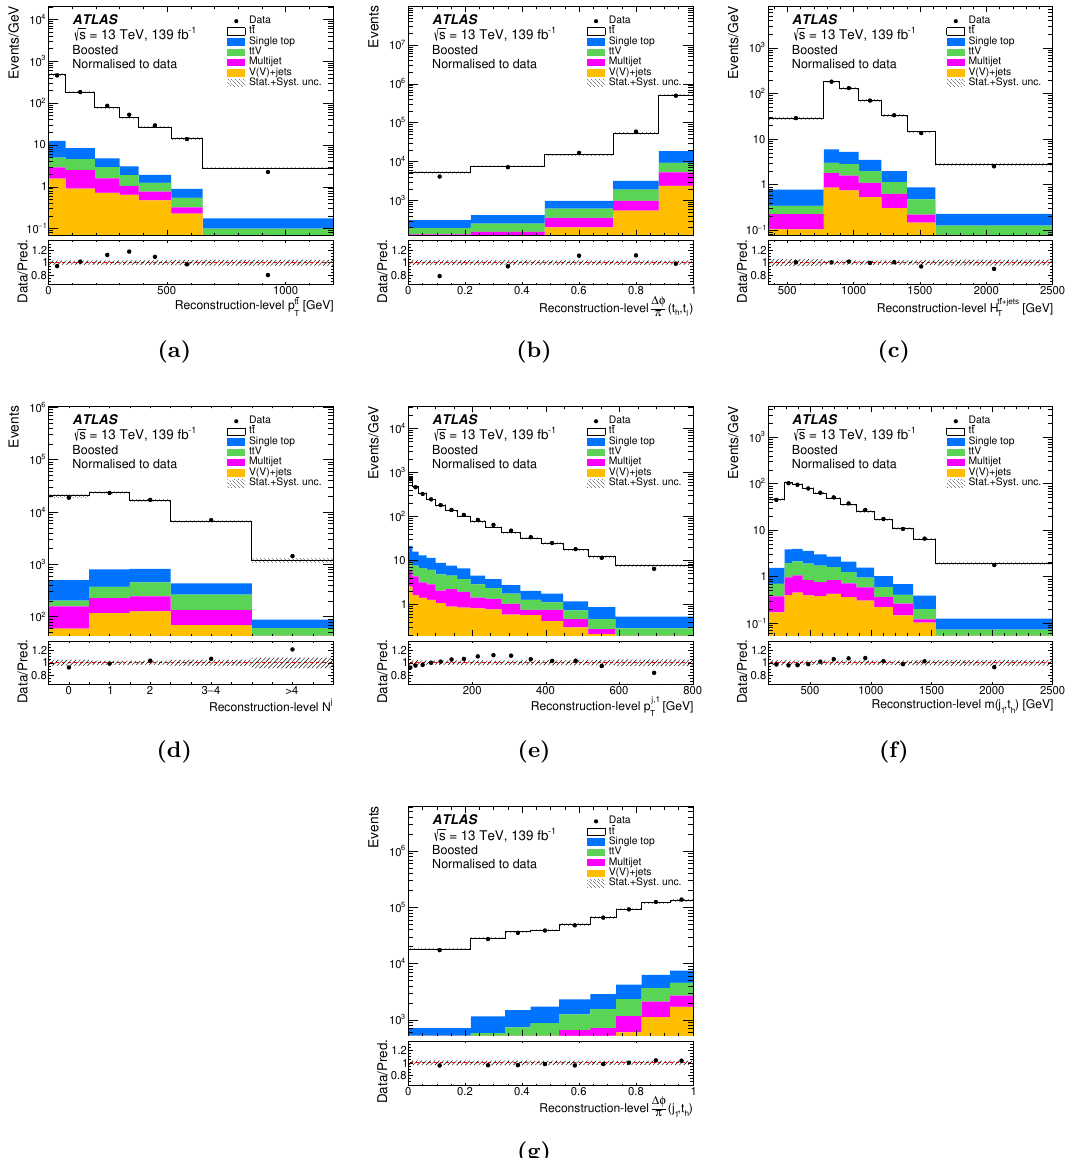
Figure 5. Distributions of observables sensitive to jets produced in association with the t ¯ t system: (a) p t ¯ t , (b) ∆ φ ( t ) , (c) H t ¯ t +jets , (d) N j , (e) p j, 1 , (f) m ( j ) and (g) ∆ φ ( j ) . The data , t , t , t h ‘ 1 h 1 h T T T are compared with the expectation from the simulation and background estimates. The total prediction is normalised to the same number of entries as the data. The lower panel in each subfigure shows the ratio of the data to the normalised expectation. The shaded band represents the uncertainties originating from the limited data sample size and systematic uncertainties ( t ¯ t modelling uncertainties are not